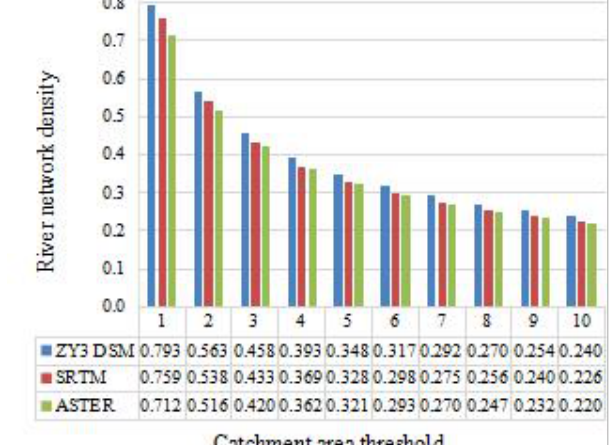
Figure 6. River networks